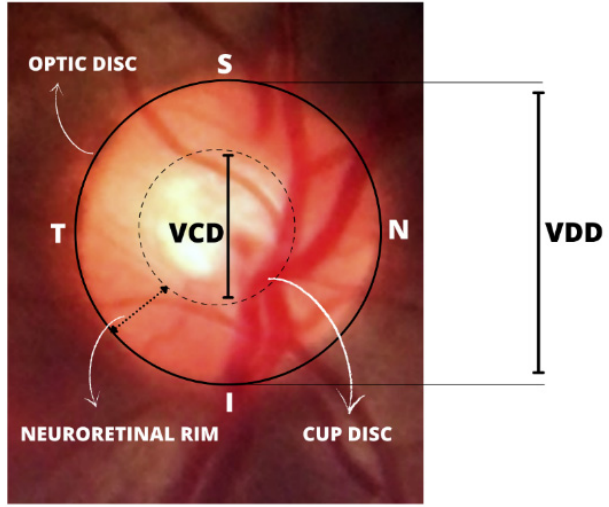
Figure 1. Illustration of the inferior, superior, nasal, temporal (ISNT) rule pattern and important structures for the diagnosis of glaucoma.